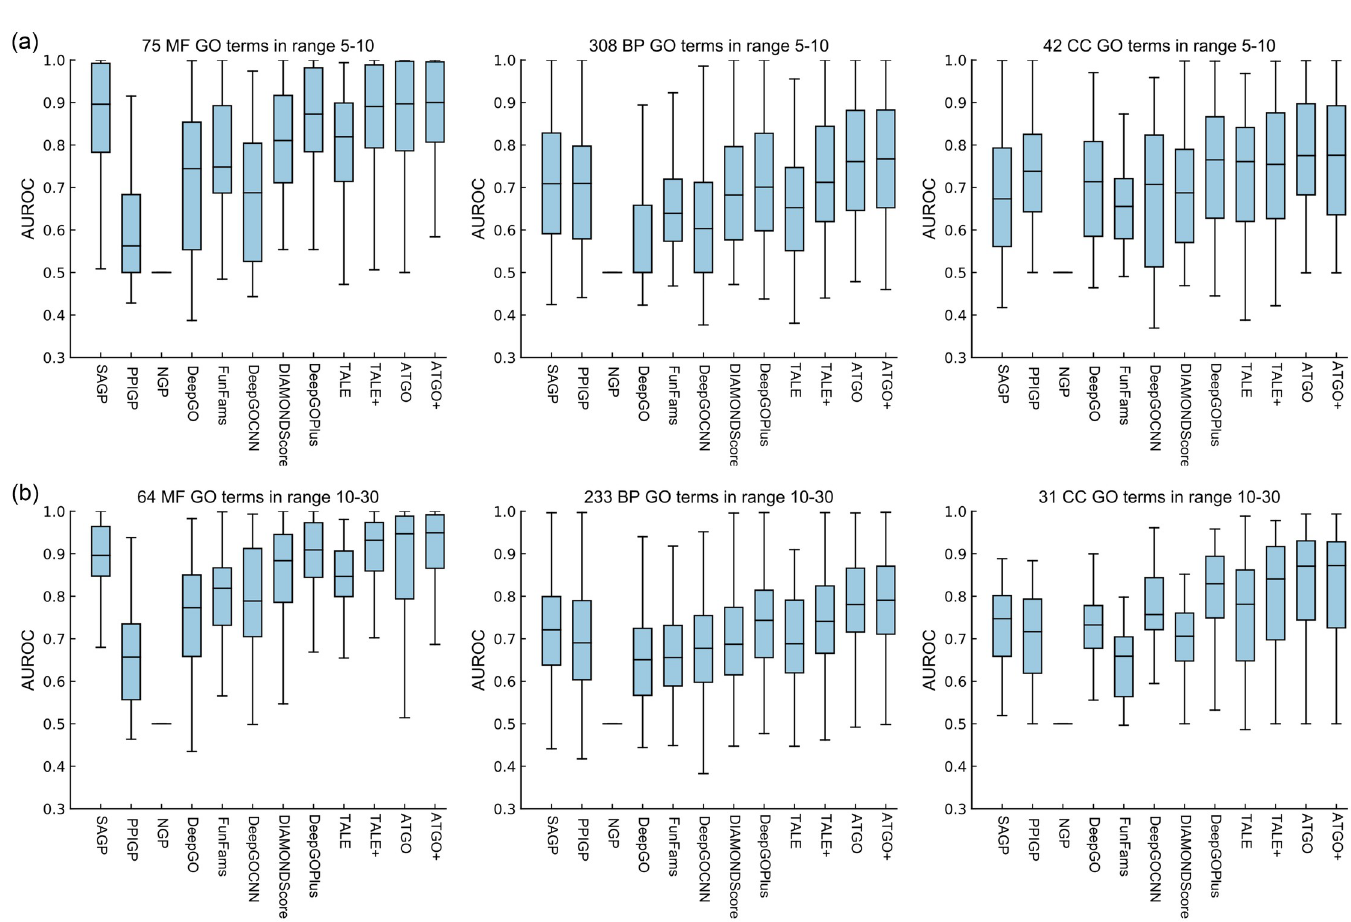
Fig 3. AUROC values by different methods for the rare GO terms in terms of the number of associated proteins, where the median line in the box is the median AUROC value. (a) range 5–10. (b) range 10–30.